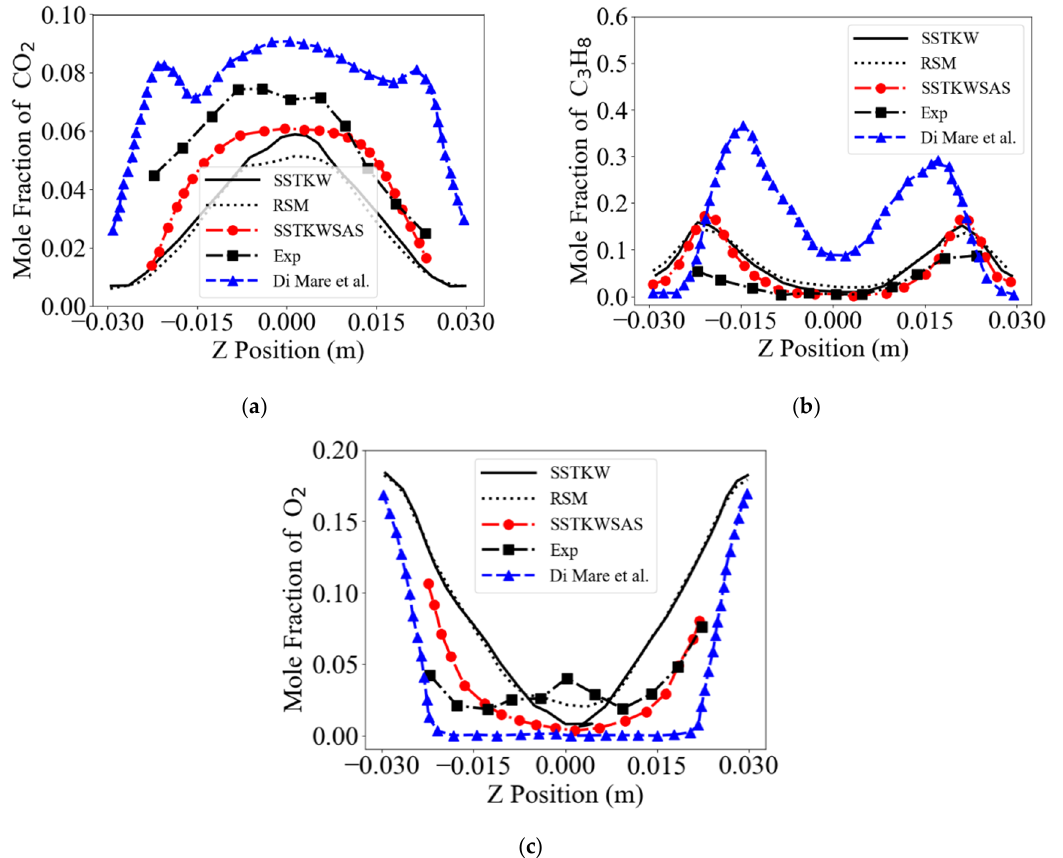
Figure 6. Profile of species mole fraction in the horizontal midplane of the combustor ( x = 20 mm). ( a ) Mole fraction of CO 2 , ( b ) Mole fraction of C 3 H 8 , ( c ) Mole fraction of O 2 .